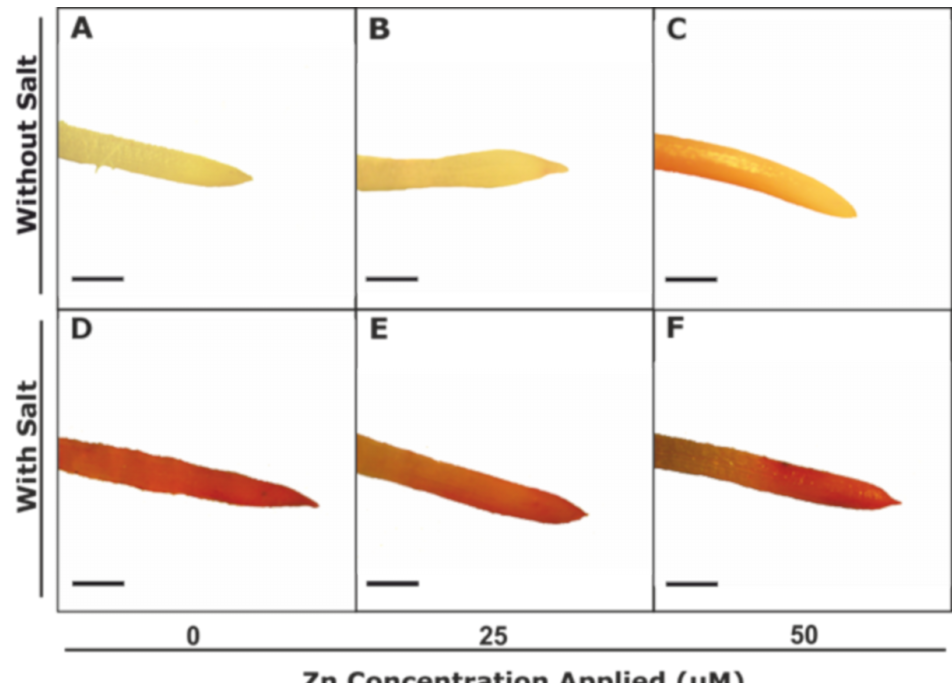
Figure 3. Lipid peroxidation of pak choi roots under di ff erent treatments of Zn and / or salts. Red colours show peroxidation areas. ( A ) control roots. ( B , C ) roots under not salinity condition with Zn application.